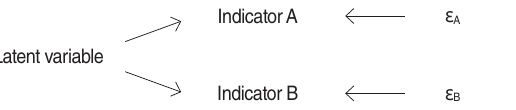
Figure 2. Types of violation of the local independence assumption. (A) Behaviorally correlated error, (B) bivocality, and (C) latent hetero- geneity. ε , measurement